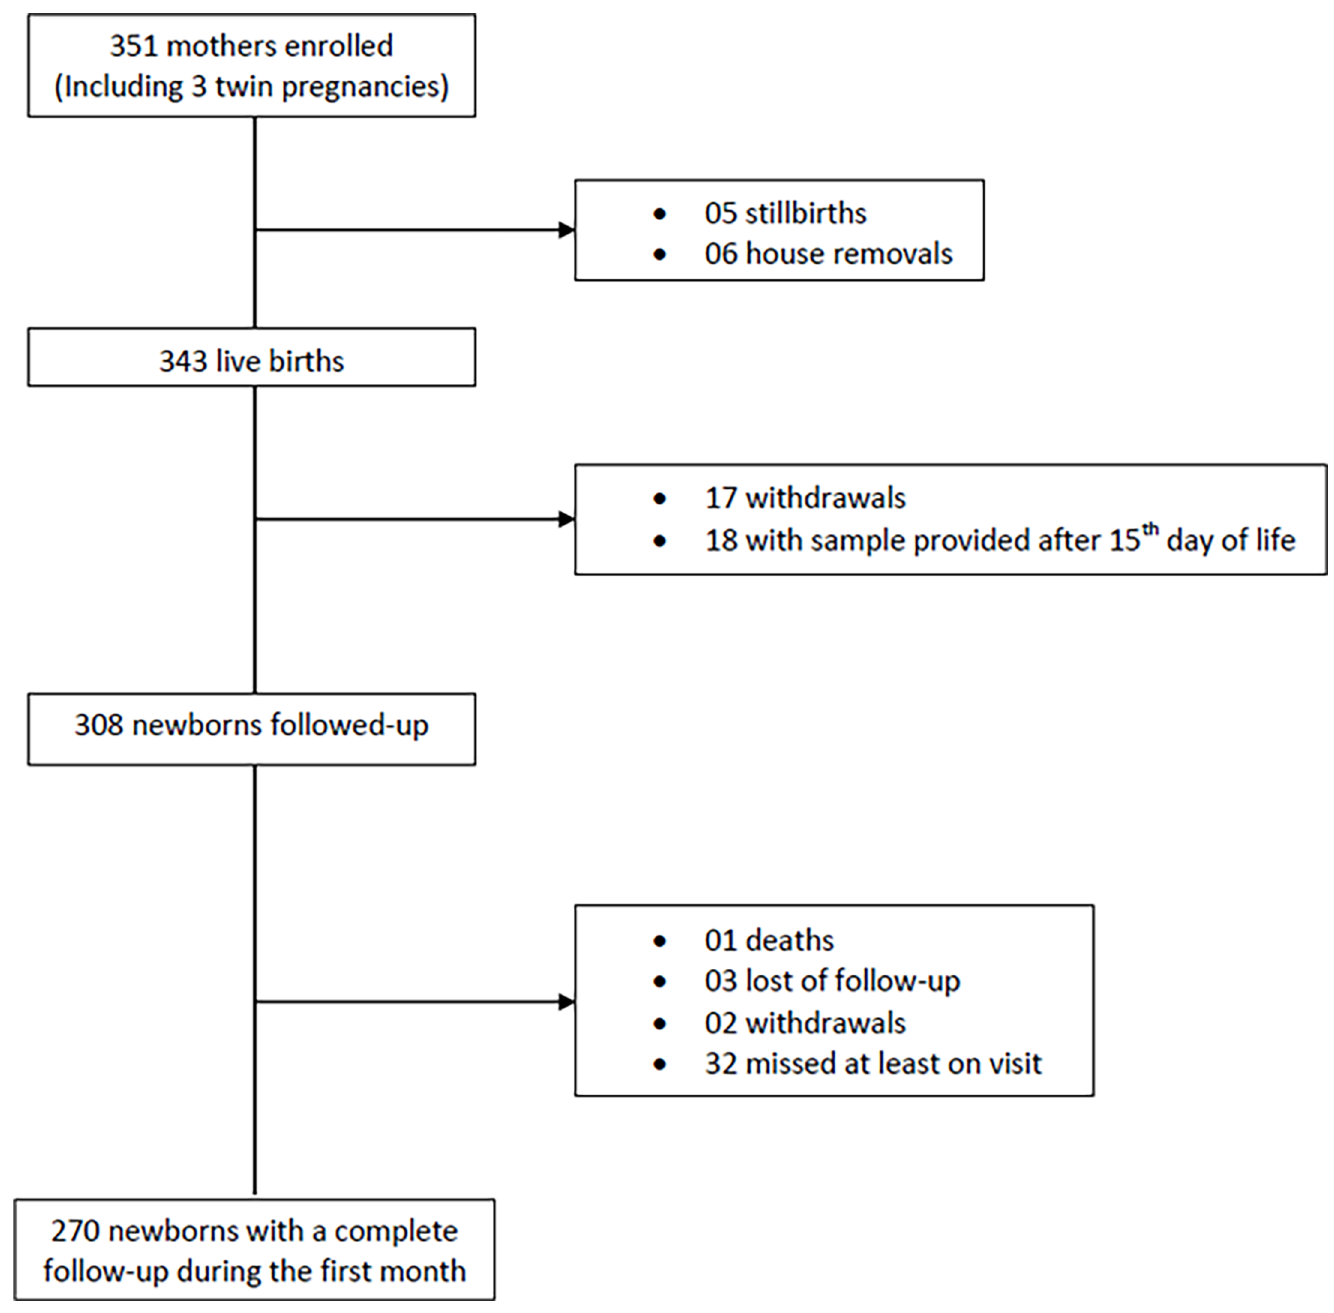
Fig 2. Flow-chart of the study participants. 3D and Fig 3E, respectively. In univariate Cox analysis (Table 2), cesarean-born babies (Haz- ard-ratio (HR) = 3.5, 95% CI [1.7; 6.8]) or newborn from a mother who received an antibiotic during delivery (HR = 2.1, 95% CI [1.0; 4.2]) were at higher risk of ESBL-PE acquisition than vaginally born babies or newborn from a mother who did not receive an antibiotic during delivery, respectively. Compared to babies born from a mother not colonized with ESBL-PE, children born from an ESBL-PE colonized mother had an increased risk of acquiring ESBL-PE